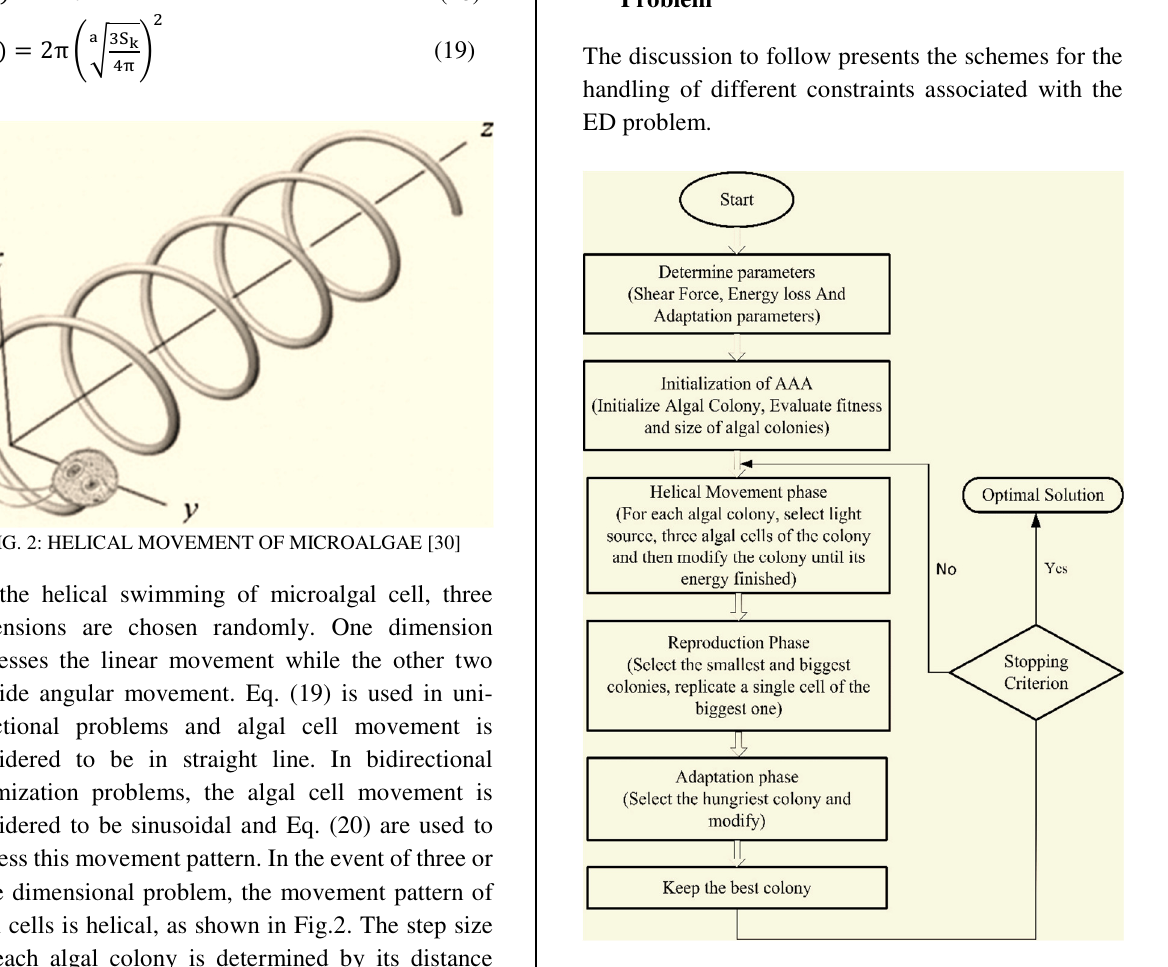
FIG. 3: FLOWCHART OF